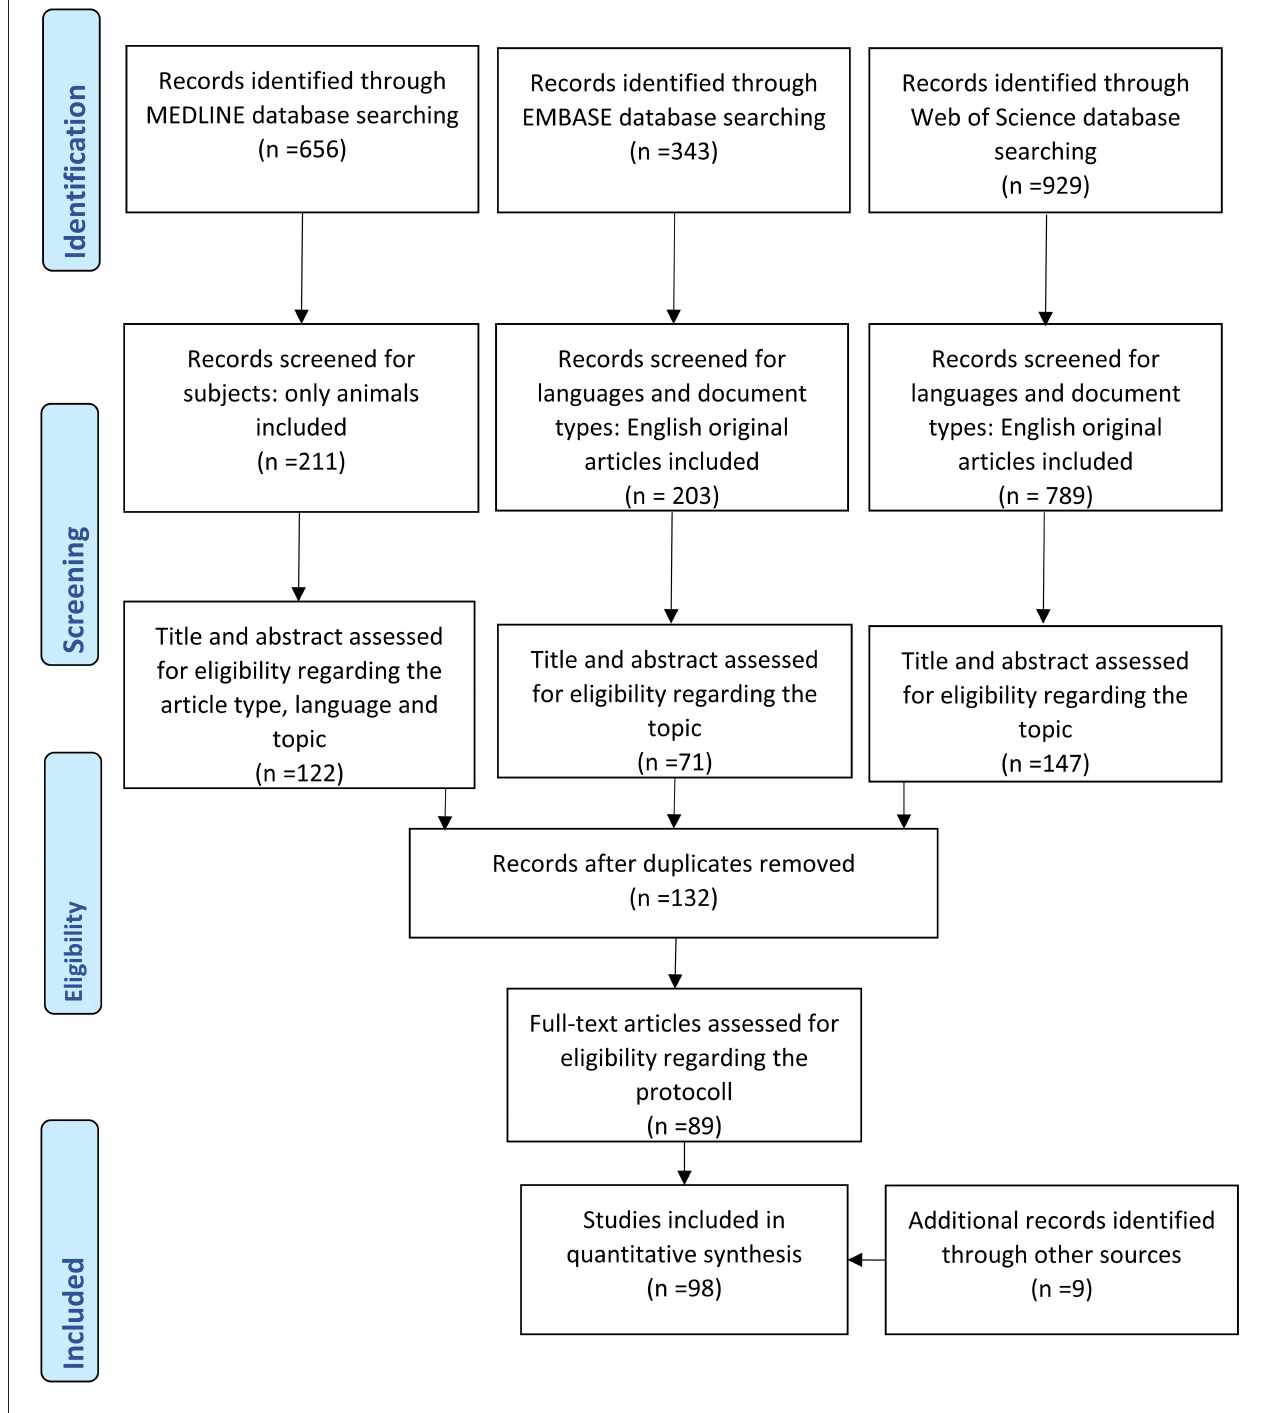
FIGURE 1 | PRISMA flow